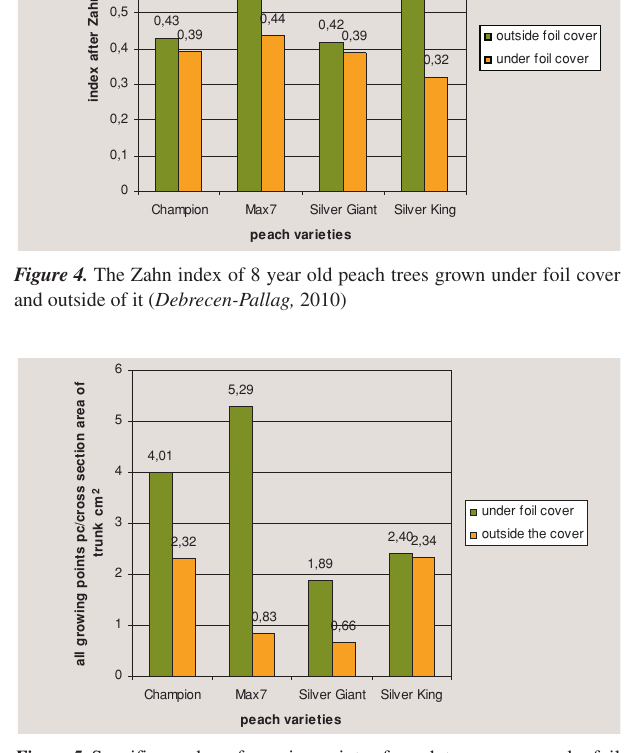
cover or outside the cover at an age of 8 years ( Debrecen-Pallag, 2010)